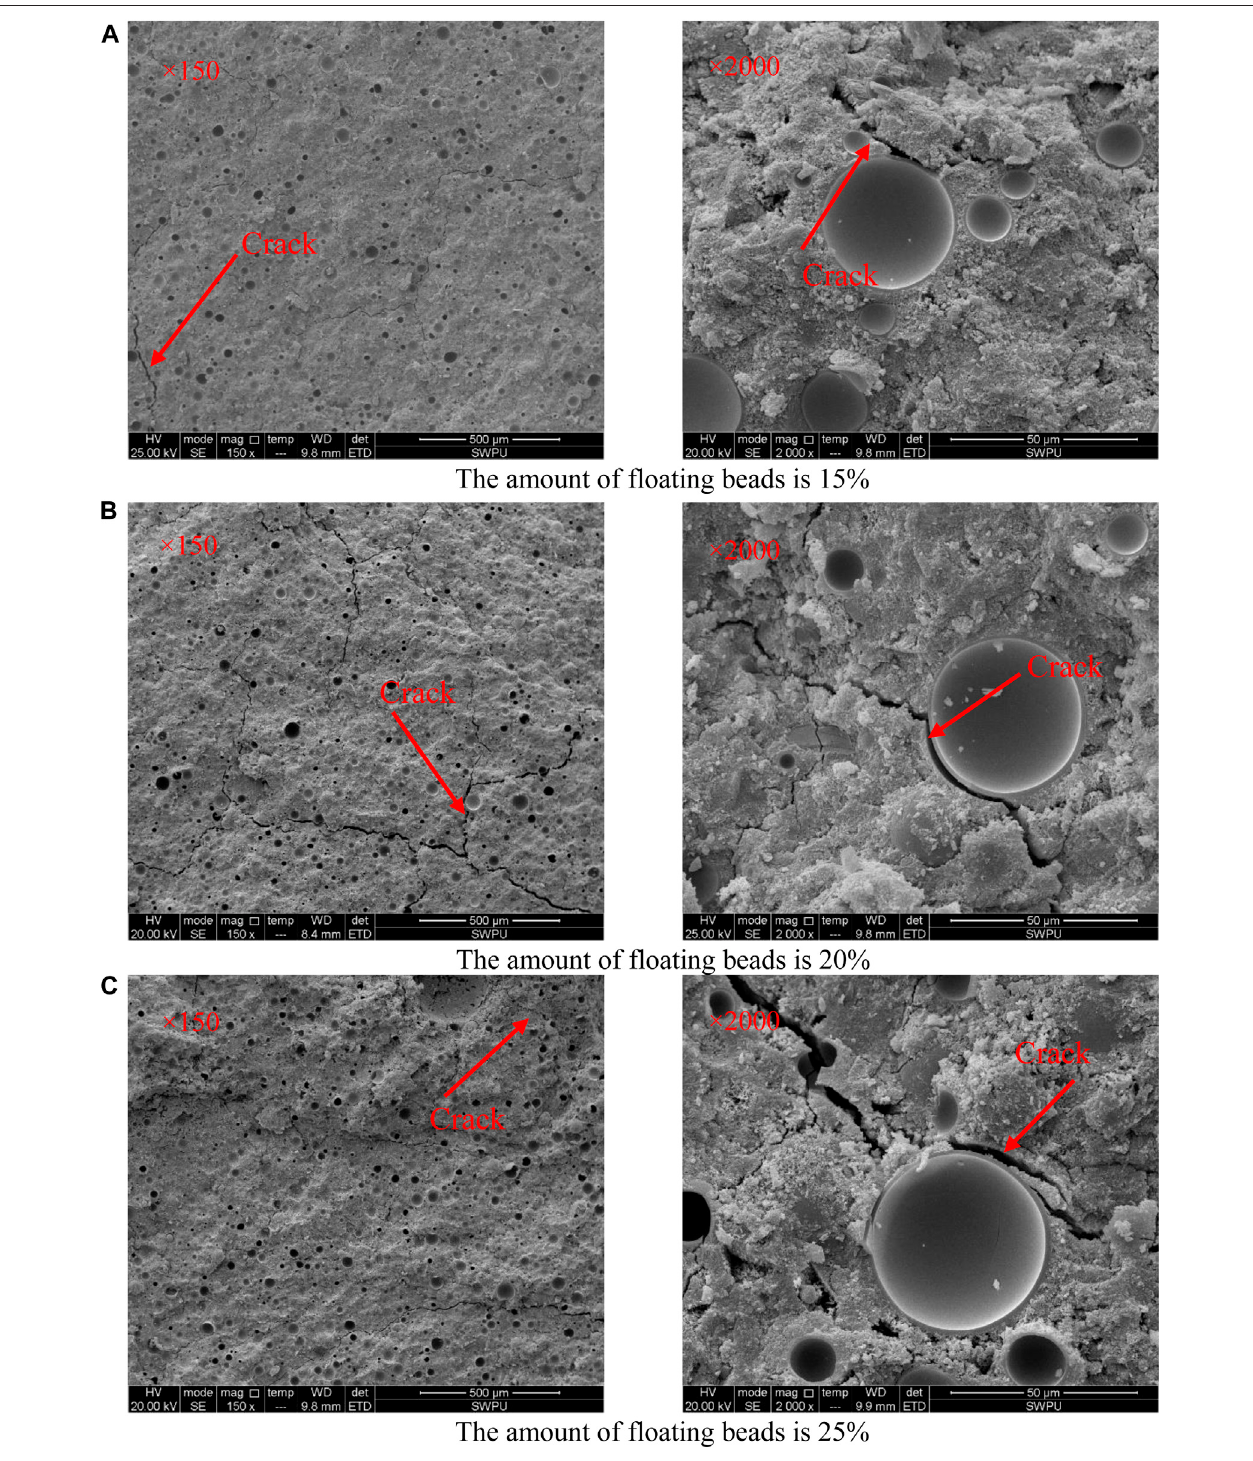
FIGURE10| Themicroscopicmorphologyofcementstonemixedwithdifferent fl oatingbeads. (A) Theamountof fl oatingbeadsis15%. (B) Theamountof fl oating beads is 20%. (C) The amount of fl oating beads is 25%.